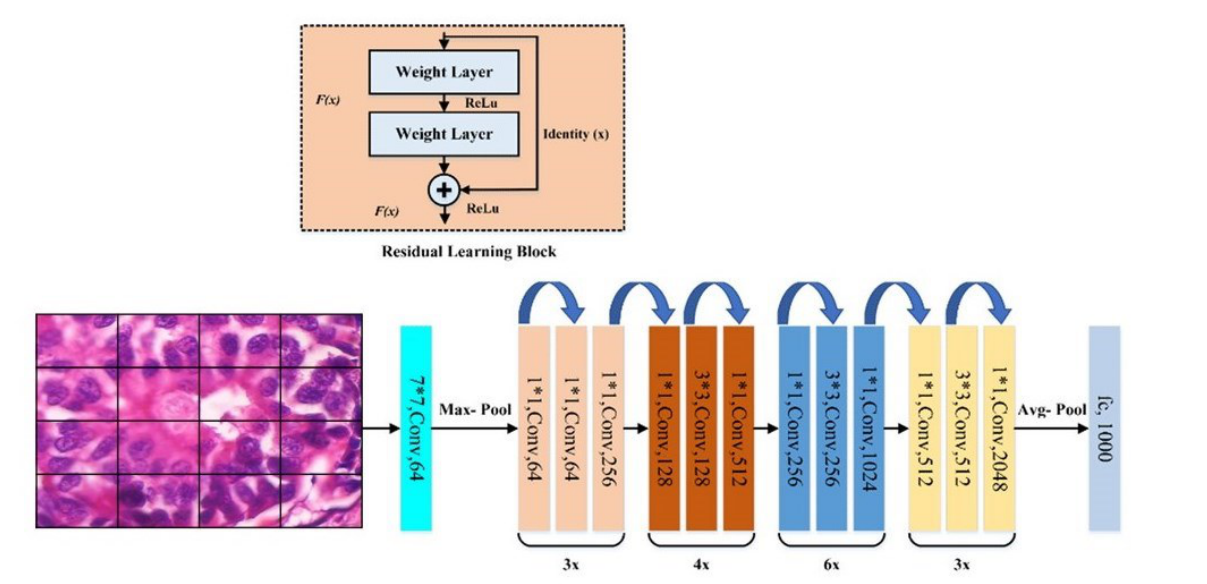
Figure 8. ResNet50